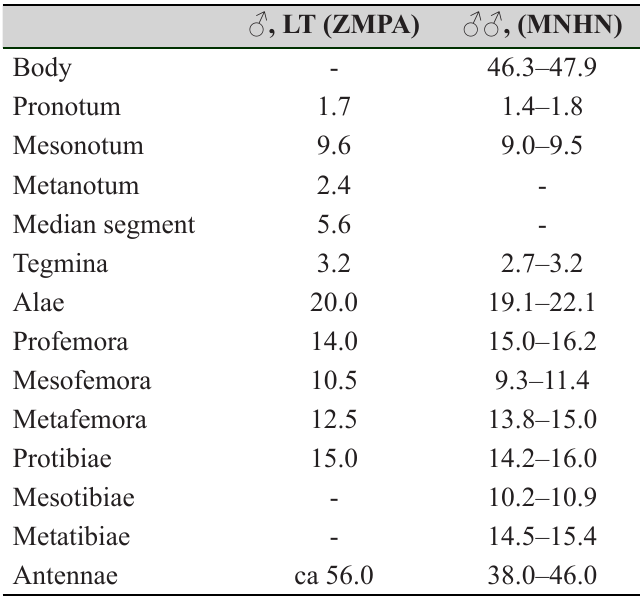
Table 9 . Measurements of Phantasca poeciloptera (Günther, 1940) (in mm). LT =